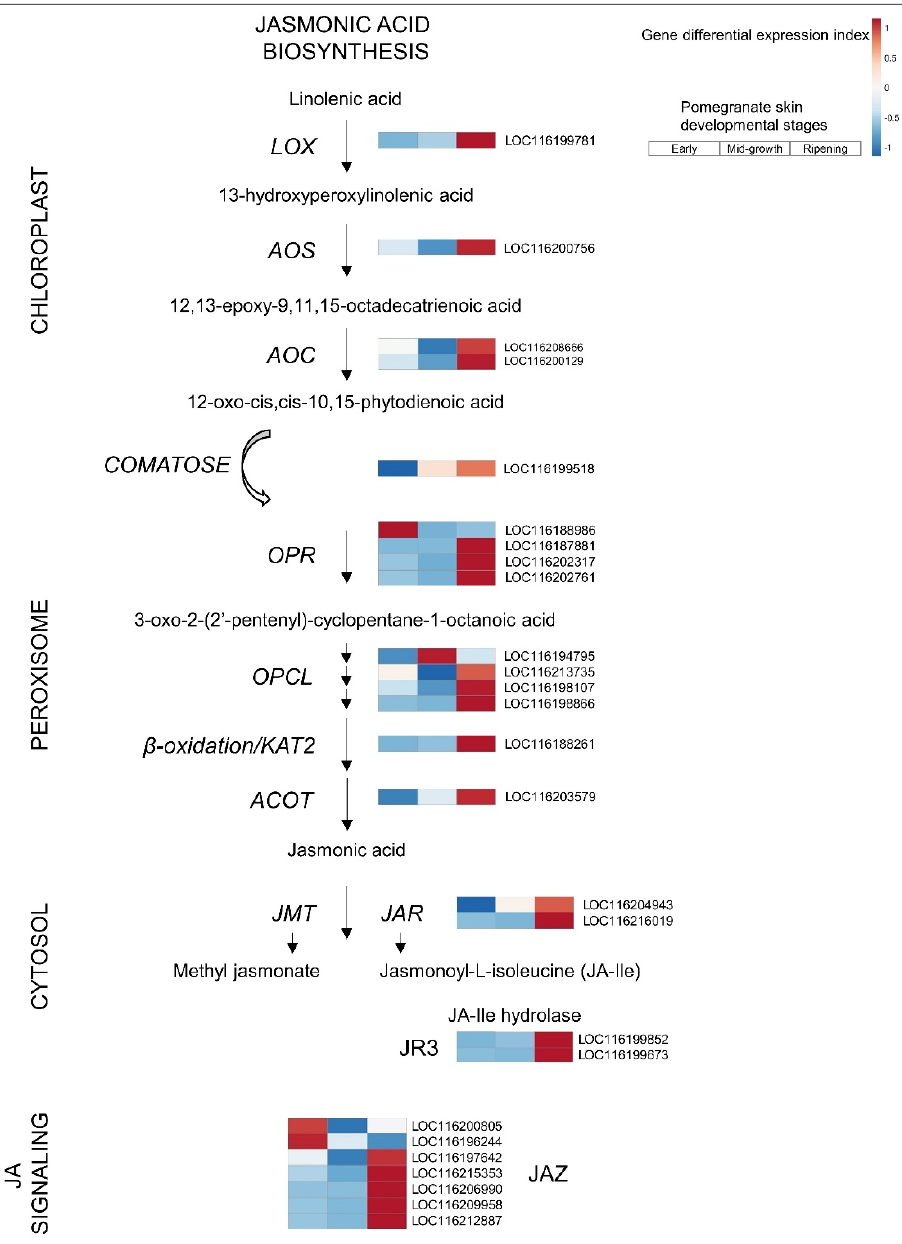
Figure 5. Jasmonic acid biosynthesis and signaling in pomegranate skin. See Figure 3 legend for details. Expression level values and full gene names are given in Table S7.